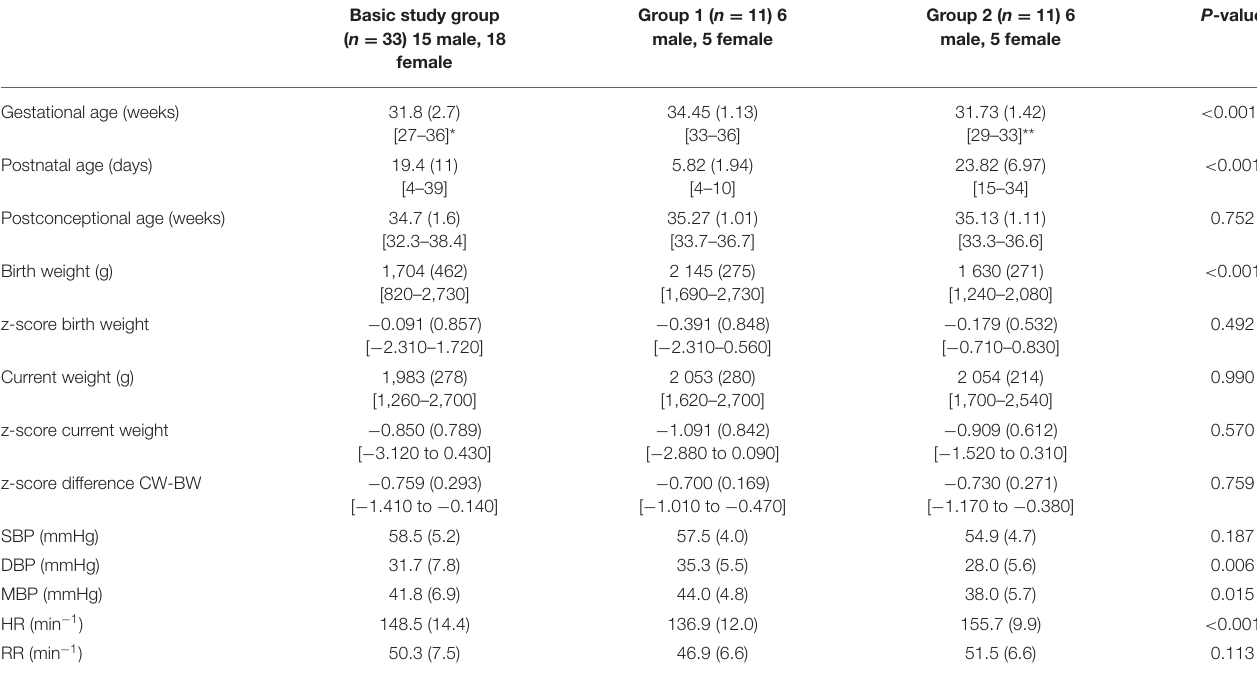
P-values correspond to between groups testing (Group 1 vs. Group 2). SBP, systolic blood pressure; DBP, diastolic blood pressure; MBP, mean blood pressure; HR, heart rate; RR, respiratory rate. * included 14 children with gestational age in the range 28–31 weeks; 1 child with gestational age below 28 weeks; ** included 5 children with gestational age < 32 weeks. a indicates Mann-Whitney U-test used for between groups difference testing.